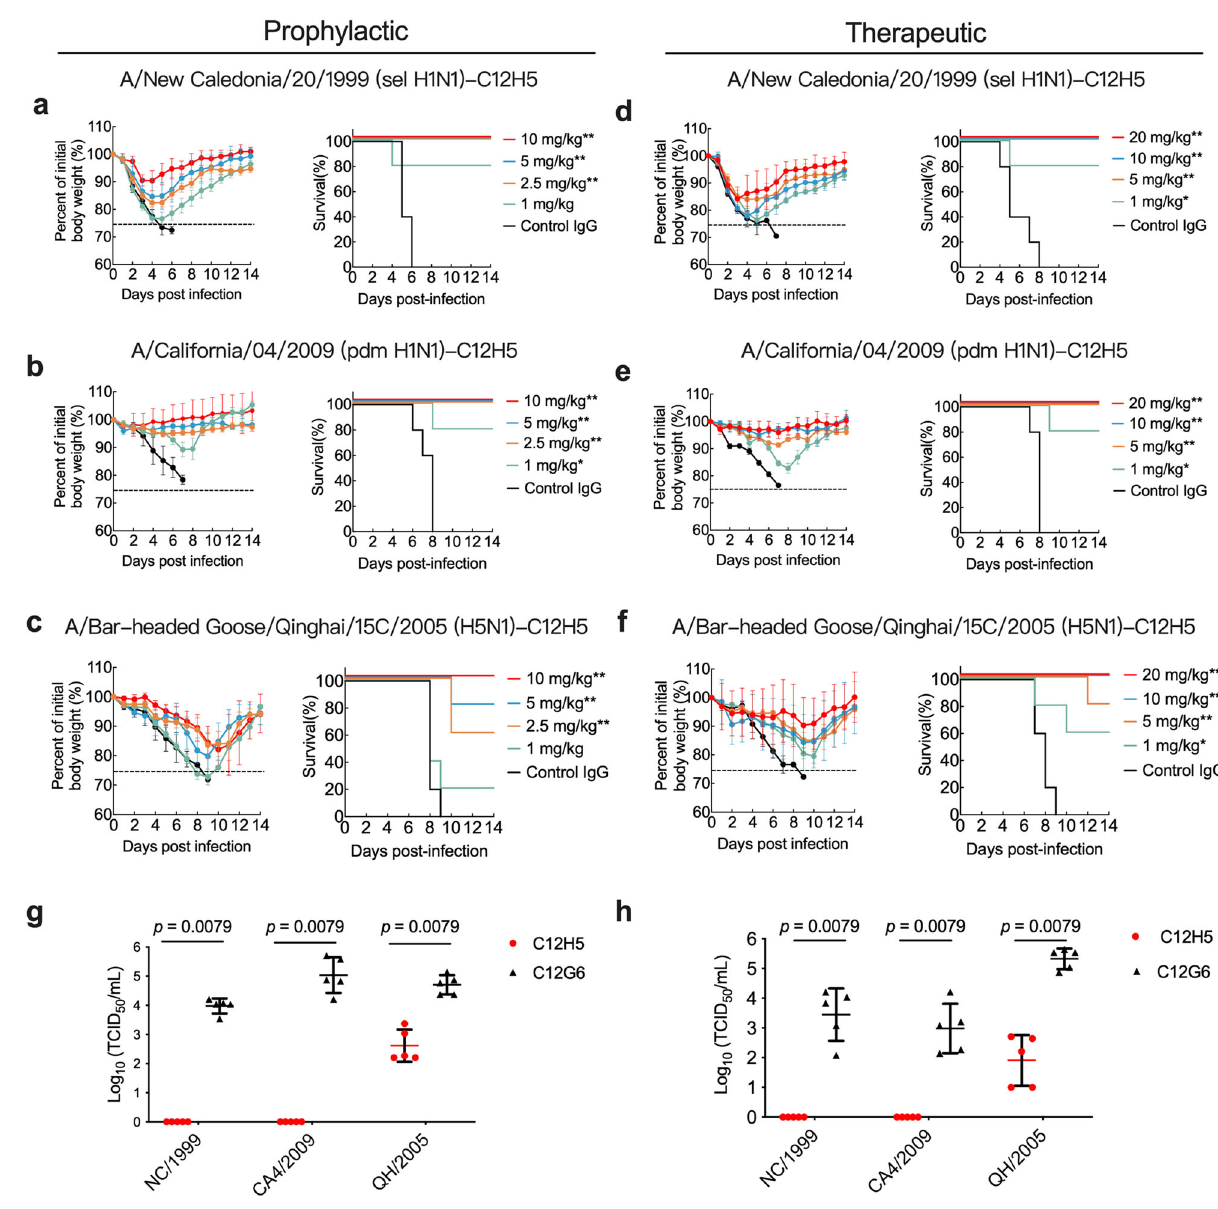
Fig. 2 | In vivo prophylactic and therapeutic ef fi cacy of C12H5 in mice. a to c Prophylactic ef fi cacy of C12H5 against lethal challenge of MA-NC/1999 ( a ), MA- CA4/2009( b ),or MA-QH/2005( c ).Body weight(left)and survival(right)curves of BALB/c mice ( n =5 per group) treated with 10, 5, 2.5, or 1mg/kg C12H5, or C12G6 (10mg/kg) 24h before lethal challenge are shown. d to f Therapeutic ef fi cacy of C12H5 against lethal challenge with MA-NC/1999 ( d ), MA-CA4/2009 ( e ), and MA- QH/2005( f ).Bodyweight(left)andsurvival(right)curvesofBALB/cmice( n =5per group) treated with 20, 10, 5, or 1mg/kg C12H5, or C12G6 control (20mg/kg) 24h after lethal challenge are shown. The body weight curves in a – f re fl ect the weights of surviving mice; data pertaining to the mice that died after challenge were